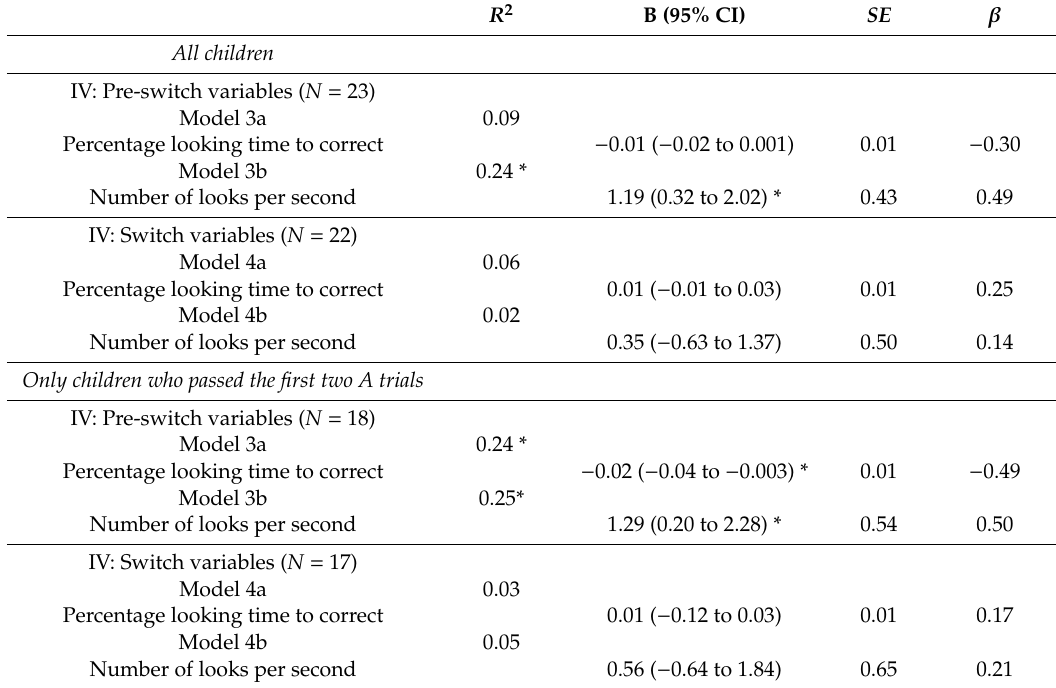
Table 4. Results of univariate linear regression analyses predicting total number of switches